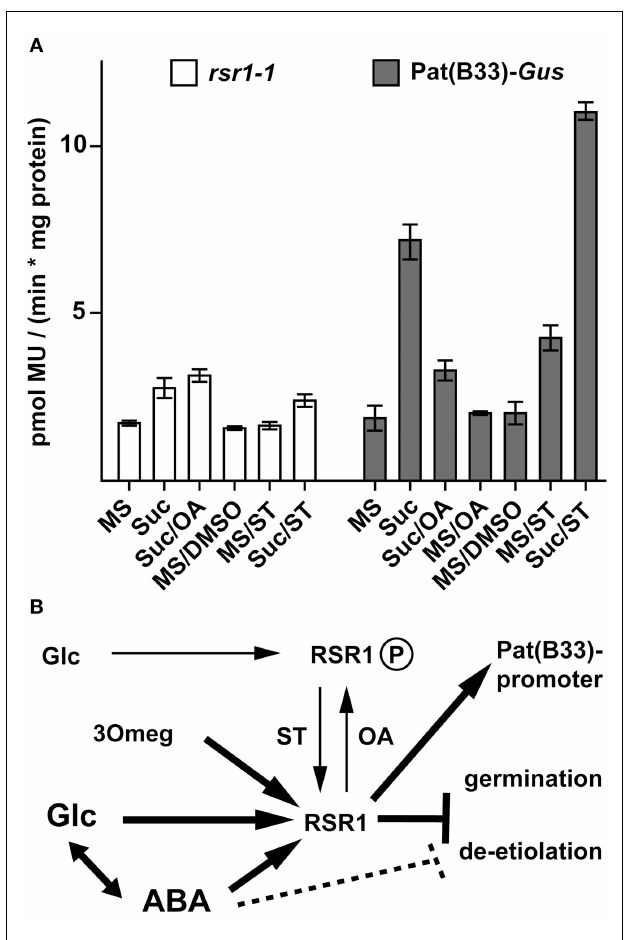
FIGURE 8 | Proteinphosphatases and kinases regulate RSR1-mediated effects. (A) To determine expression levels of the Pat(B33)- Gus transgene, GUS-activity was determined in roots after 30h incubation with liquid MS-medium supplemented with either 200mM Suc, 0.4mM okadaic acid (OA), 0.001% DMSO, 0.4mM staurosporine (ST, in 0.001% DMSO) or combinations of inhibitors with 200mM Suc. For details see Section “Materials and Methods.” OA suppressed Suc-dependent induction of GUS expression in Pat(B33)- Gus whereas rsr1-1 mutants were insensitive to ST-dependent stimulation of GUS-activity.The values presented are the mean ± SD of ≥ 4 biological replicates. (B) Tentative model for the regulation of Pat(B33) promoter activity and seedling development by RSR1/ESP1. Low levels of Glc render RSR1/ESP1 inactive, potentially via phosphorylation.This effect can be mimicked by OA and overcome by ST. Intermediate levels of Glc or the Glc analog 3Omeg activate RSR1/ESP1, resulting in activation of the Pat(B33) promoter and inhibition of germination. High levels of ABA and/or Glc but not 3Omeg inhibit de-etiolation of seedlings, probably by a combinatorial effect of several